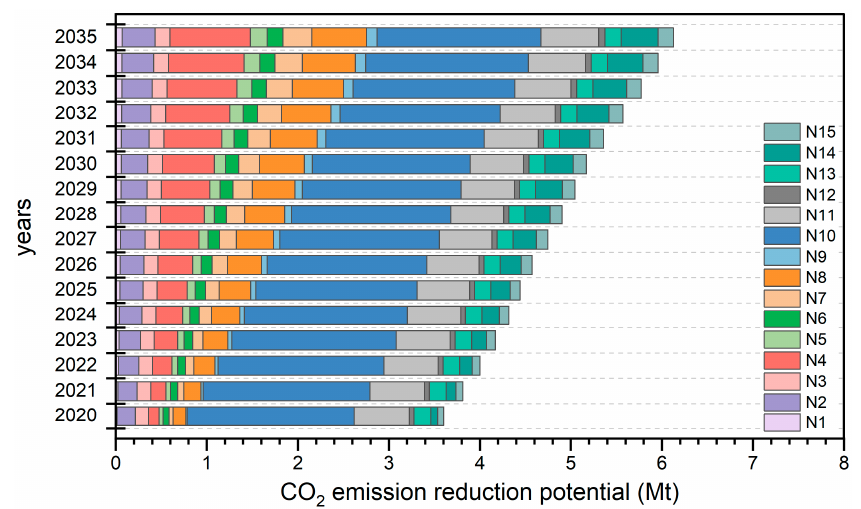
Figure 7. The 2020–2035 Shandong cement industry low-carbon technology roadmap.